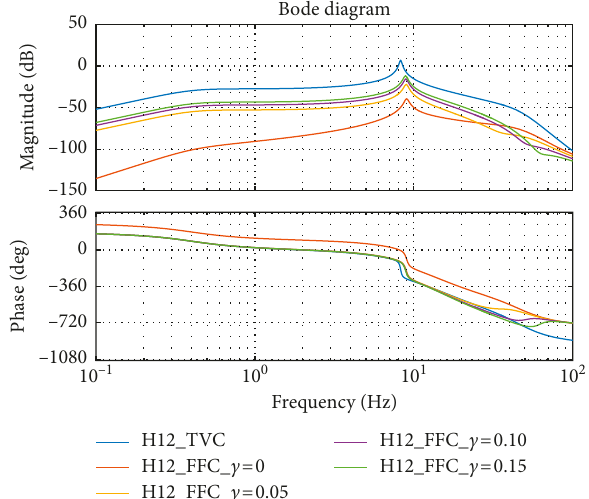
Figure 20: Effect of differential pressure sensor error on the Bode diagram of H 12 .